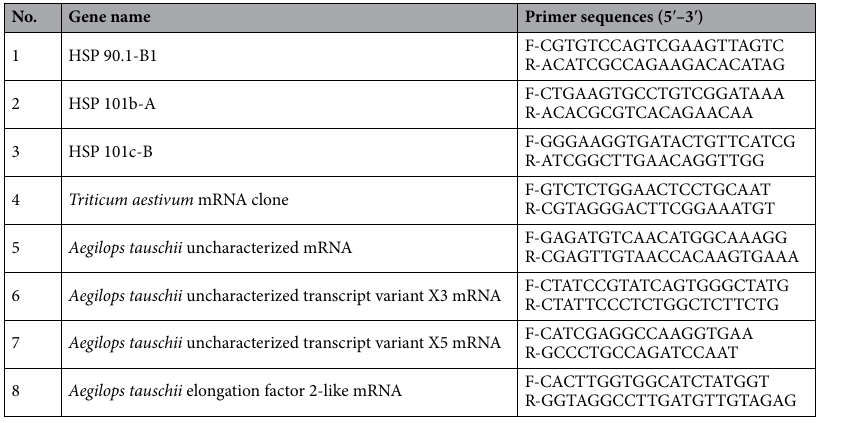
Table 1. List of the genes and specific primers used in the validation using